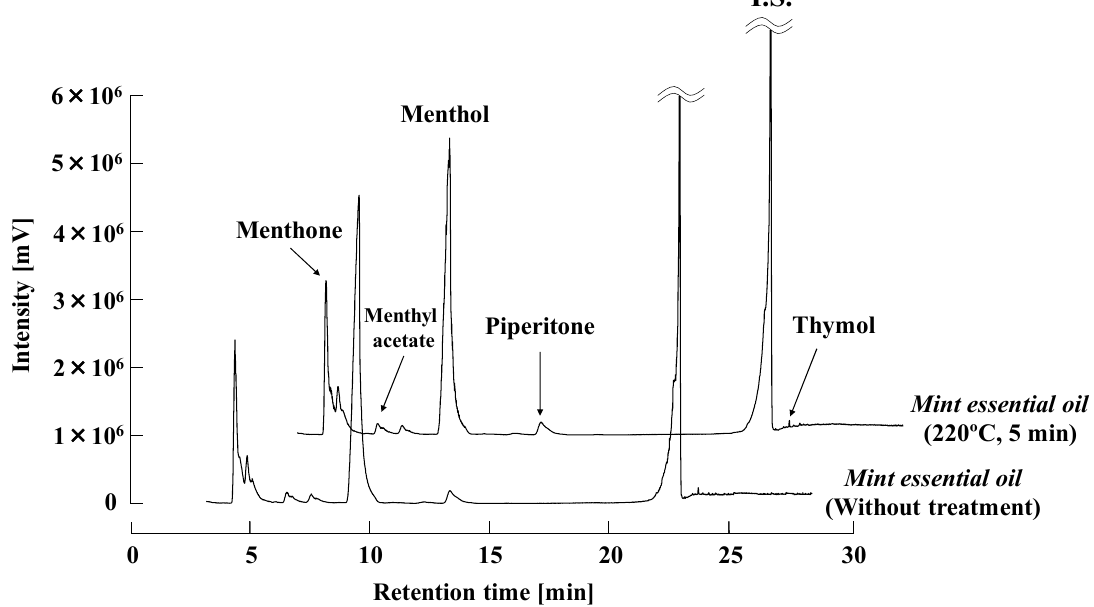
Figure 4. Thermal treatment of Japanese mint essential oil under subcritical water condition. The treatment was carried out at 220 °C for 5 min.